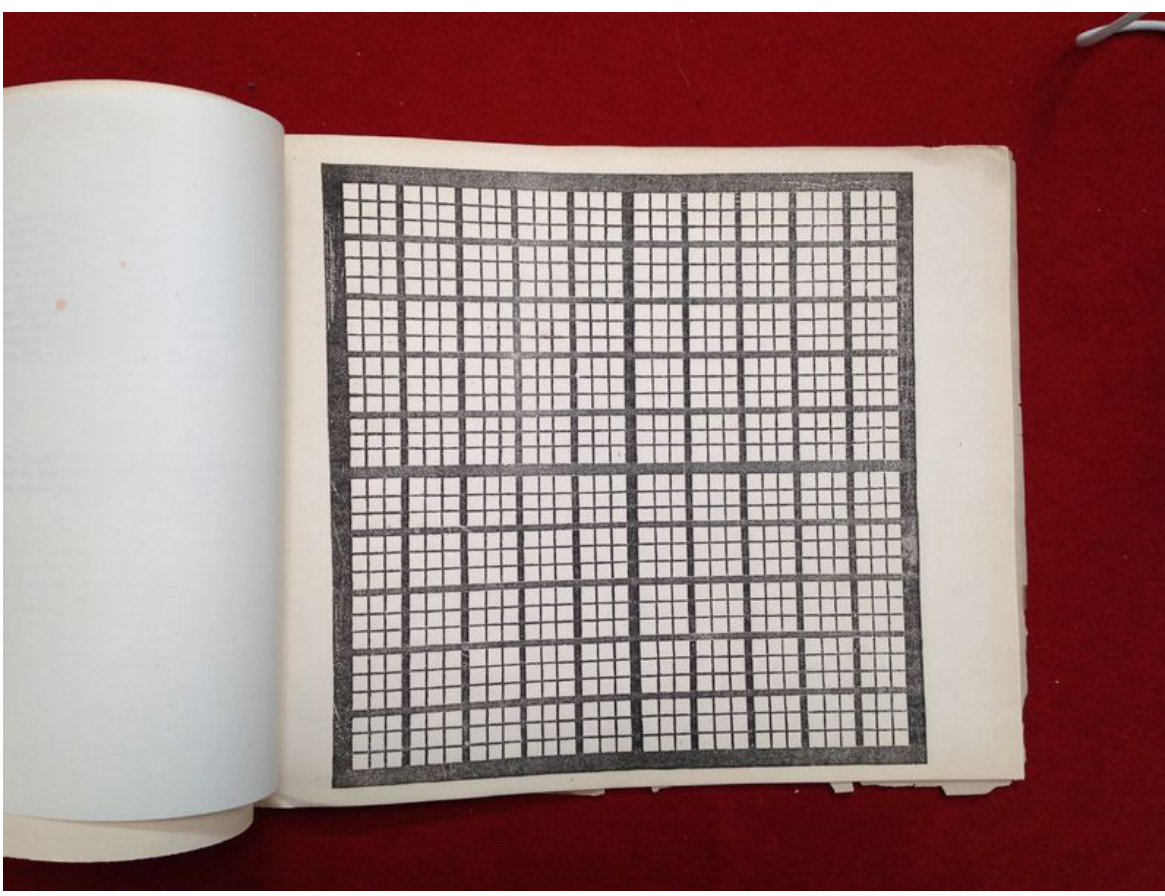
Figure 10. A blank chart from Blank Centuries for Monographs of History (1870), the workbook that Peabody printed to accompany her history textbooks. Courtesy, American Antiquarian Society. Photo by the author